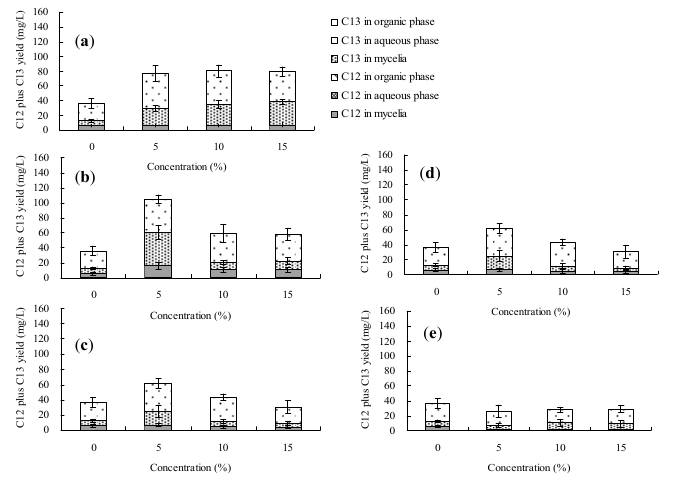
Figure 6. Effects of n -dodecane on palmarumycin production in liquid culture of Berkleasmium sp. Dzf12. n -Dodecane was applied at 0%, 5%, 10% and 15% on days 0 ( a ); 3 ( b ); 6 ( c ); 9 ( d ) and 12 ( e ) of culture, respectively. The period of culture lasted for 15 days. “C12” means palmarumycin C 12 , “C13” means palmarumycin C 13 . The error bars represent standard deviations from three independent samples.